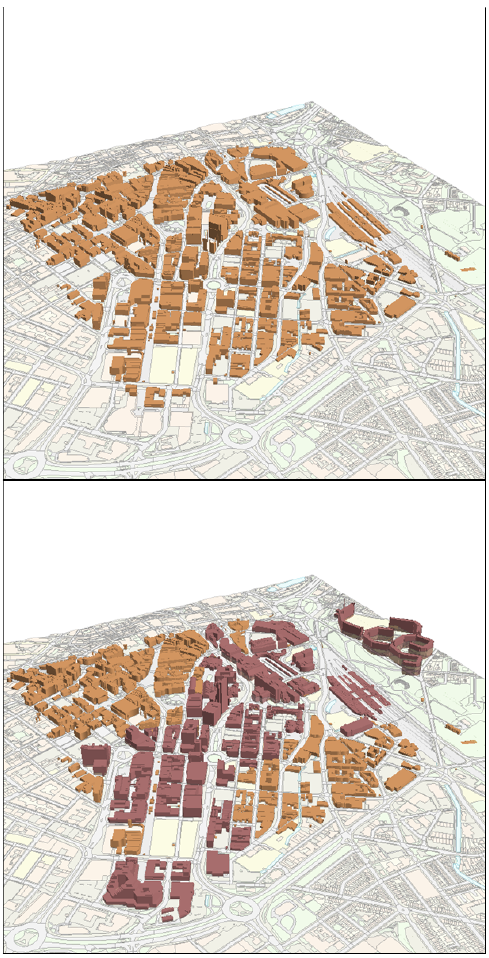
Figure 3: 3D Dataset for Sheffield, showing LoD 1 data (top) and the mix of LoD 1 and LoD 2 data (bottom)